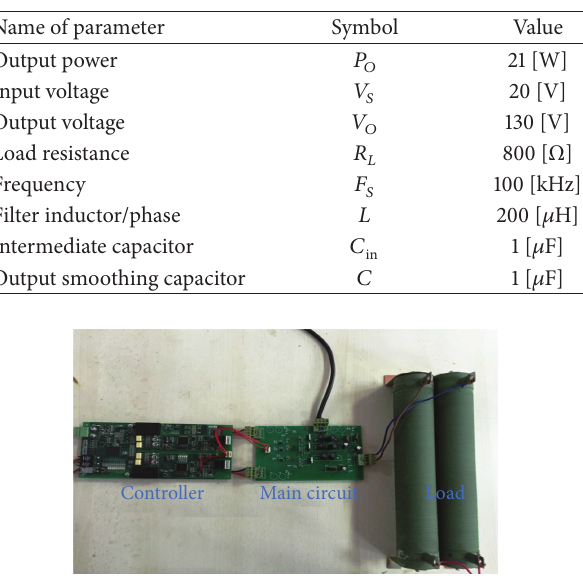
Figure 5: Photograph of prototype of the proposed